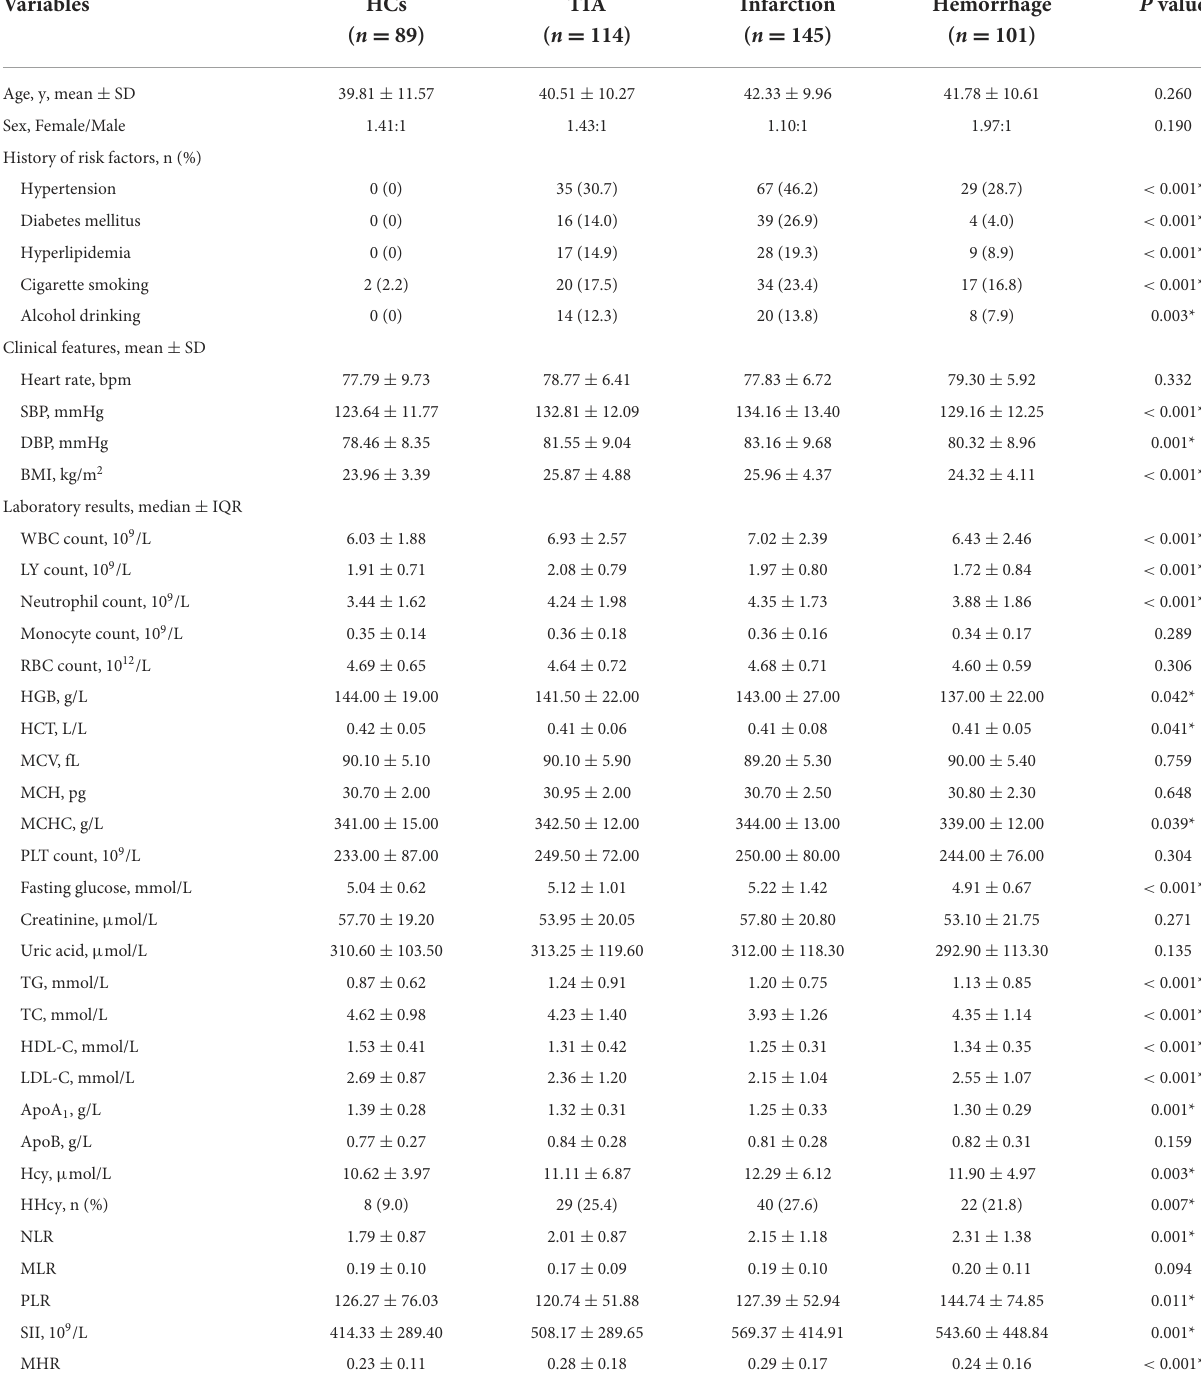
TABLE 1 Baseline characteristics of HCs and MMD